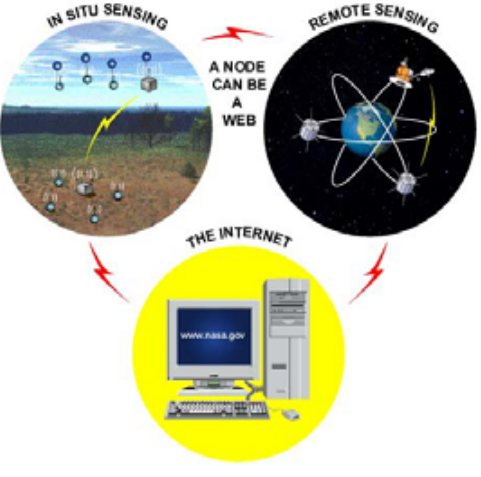
Figure 1. Generalized concept of the Sensor Web, including both orbital and terrestrial